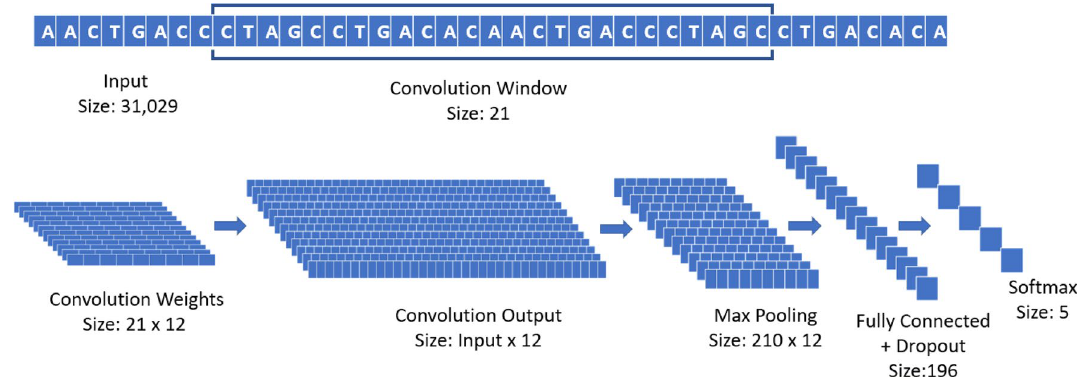
Figure 5. Graphical representation of the architecture of the CNN used in the